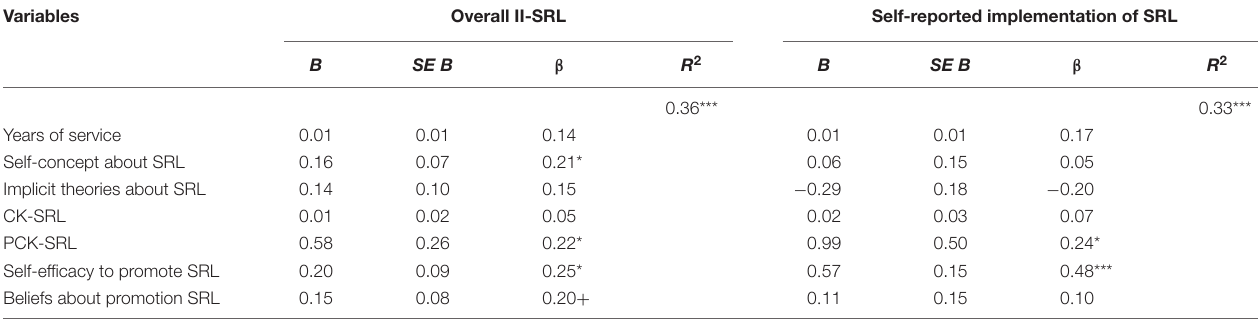
TABLE 3 | Regression analyses for the intention to implement SRL in class (overall score) and self-reported SRL implementation in class.